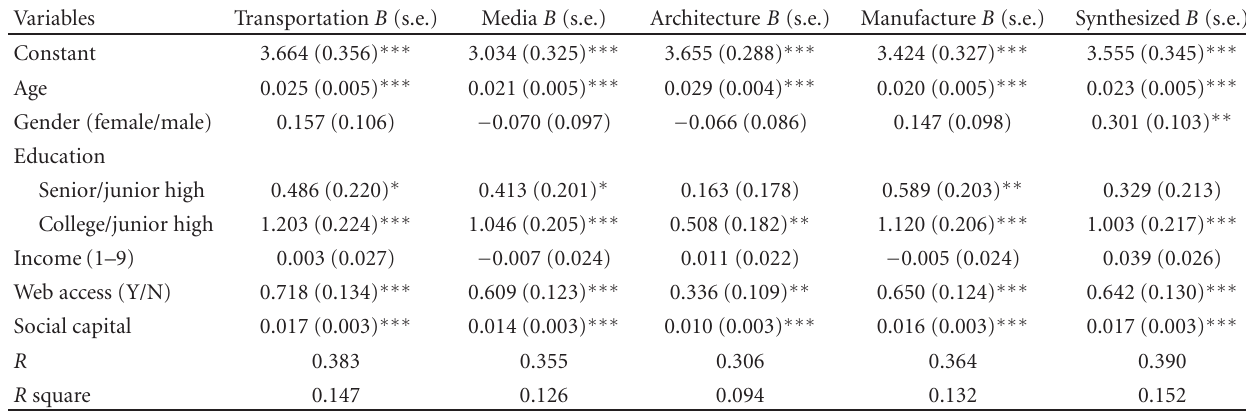
Table 5: Factors for 5 dimensions of technological